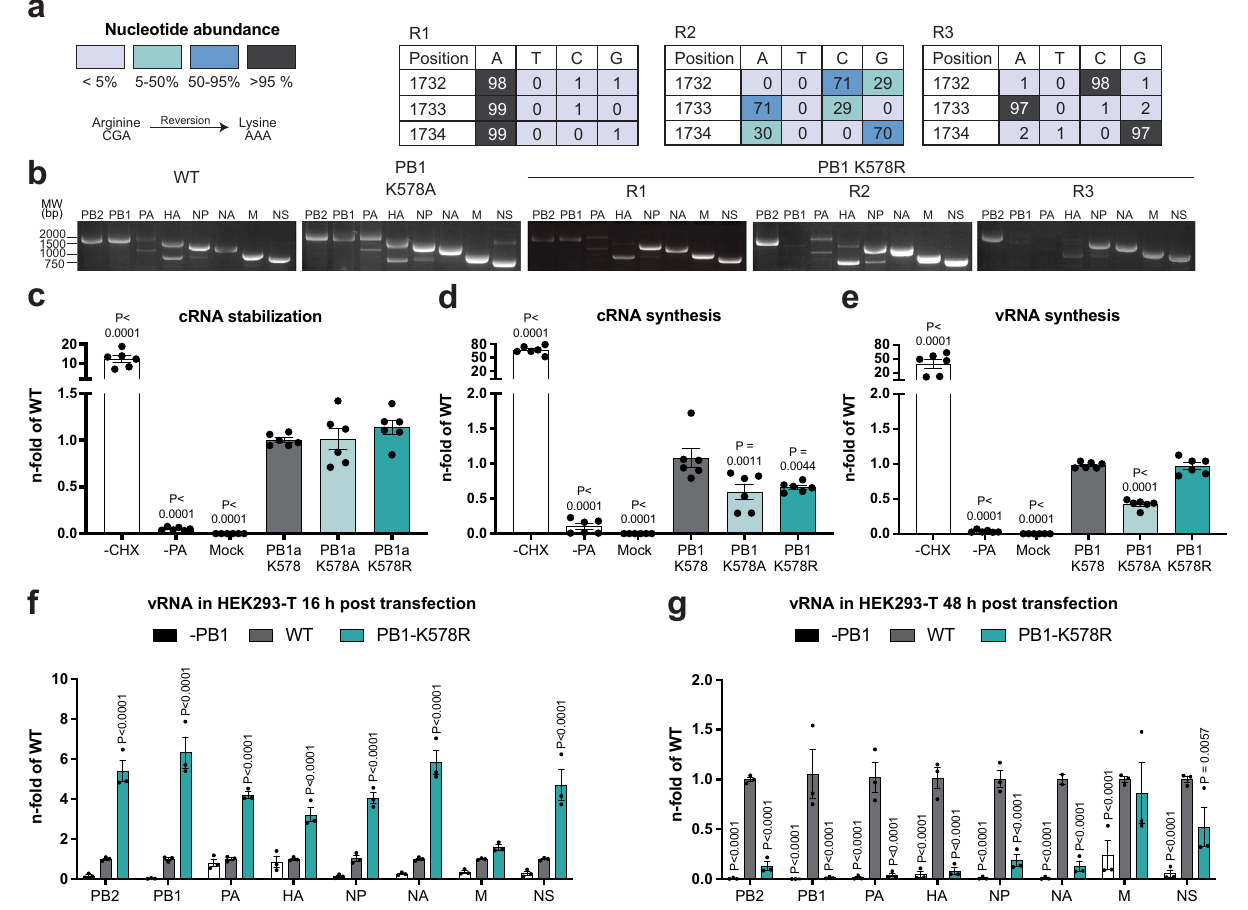
Fig. 5 | Mutation of PB1-K578 affects cRNP stabilization and vRNA synthesis. a , b DetectionofpackagedvRNAsegmentsisolatedfromreleasedvirusparticlesin the supernatants of the rescue experiments at 48h p.t. vRNA segments were ampli fi edwithsegment-speci fi cprimers,separatedon2%agarosegel( b ).Gelsfrom all three replicates of K578R and representative gels of three replicates (R) with consistentresultsareshownforWTandPB1-K578A.vRNAwasanalyzedusingdeep sequencing. Percentage of nucleotides encoded at position 1732 – 34 encoding for K578 ( a ). c – e Analysis of cRNA stabilization, cRNA and vRNA synthesis. HEK293-T cells were transfected with plasmids expressing NP, PB2, PA, inactive PB1 [PB1a] (D445A/D446A 62,100 ; c ) or active PB1 ( d , e ). At 24h p.t., cells were infected with WT WSNvirus(MOI:5)andculturedininfectionmediumwithcycloheximide(CHX).At